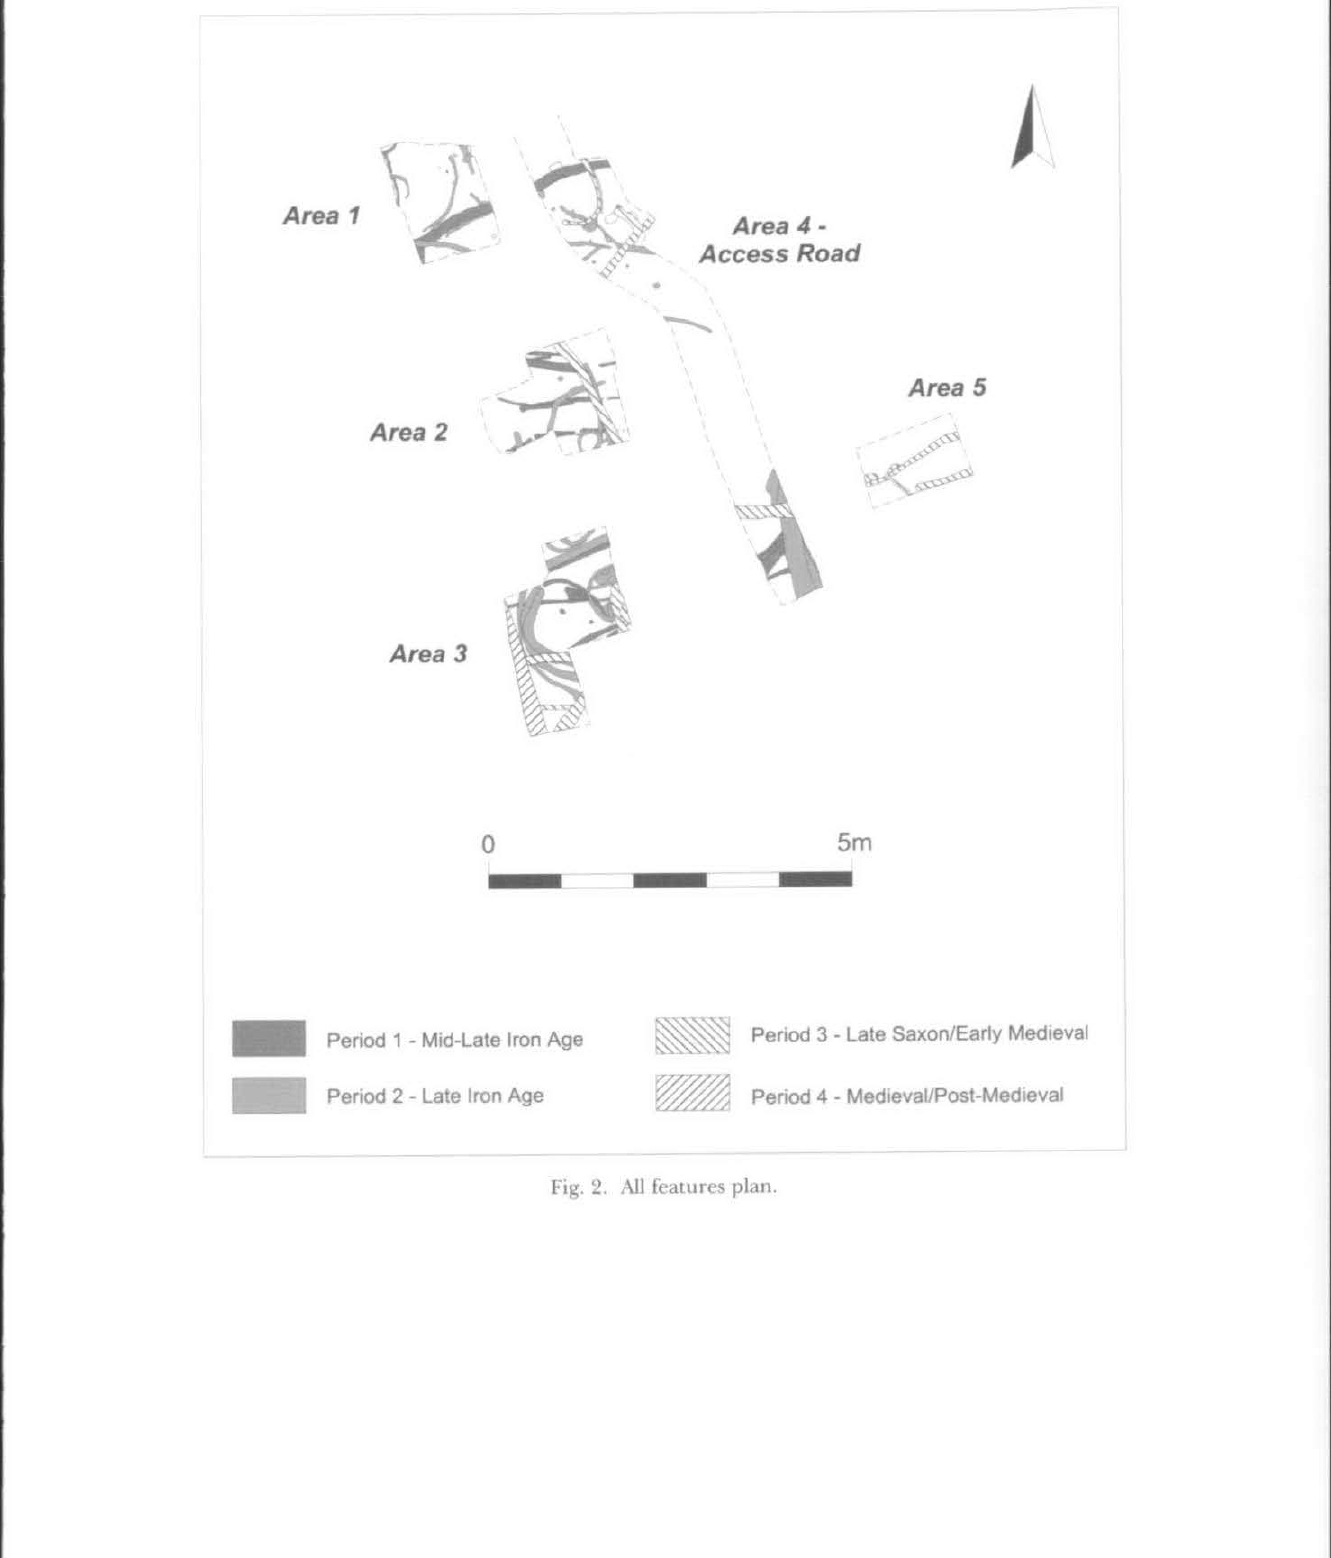
Fig. 2. All reaLUres